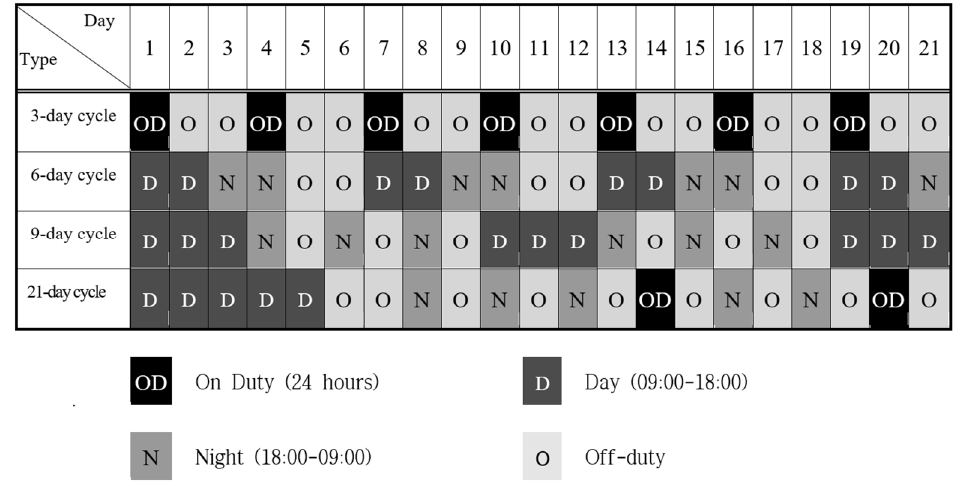
Figure 2. Shift work cycles of firefighters in South Korea .